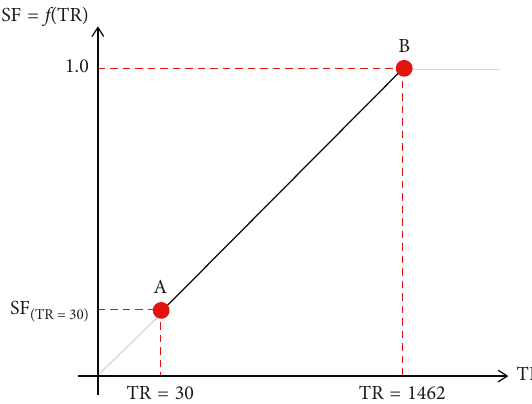
Figure 2: Scale factor for the postintervention fragility curve of all the return periods (TR in